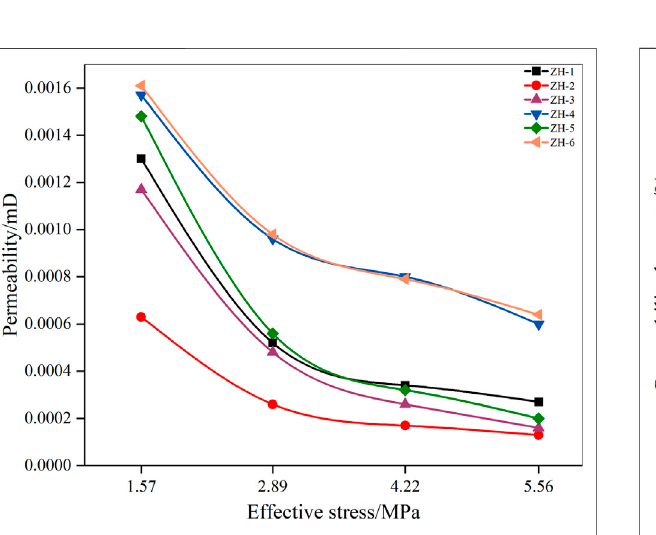
FIGURE 4 | Variation relationship of permeability versus effective stress for a single sample. (A) — mudstone; (B) — sandstone; (C) — siltstone; (D) — summary.